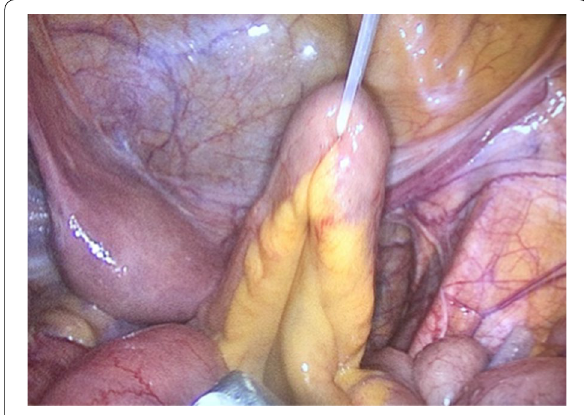
Fig. 1 Hidden ileostomy: taping the ileum loop by passing a silicone tape